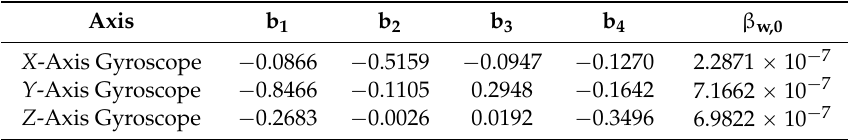
Table 5. Fourth order AR model coefficients of a three-axe